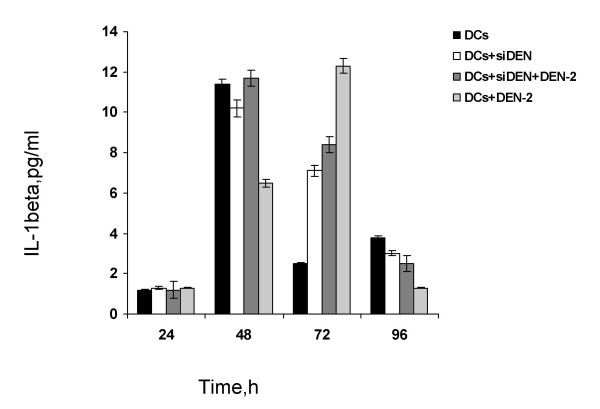
Differential expression of cytokines in the supernatants of infected DCs. Supernatants from DEN-2-infected DCs with or without siDEN treatment were harvested at the indicated time points and analyzed by CBA and ELISA to measure the concentrations of cytokines. Data are the averages of two independent experiments. **p < 0.01 in comparison with the value of DCs within individual group.